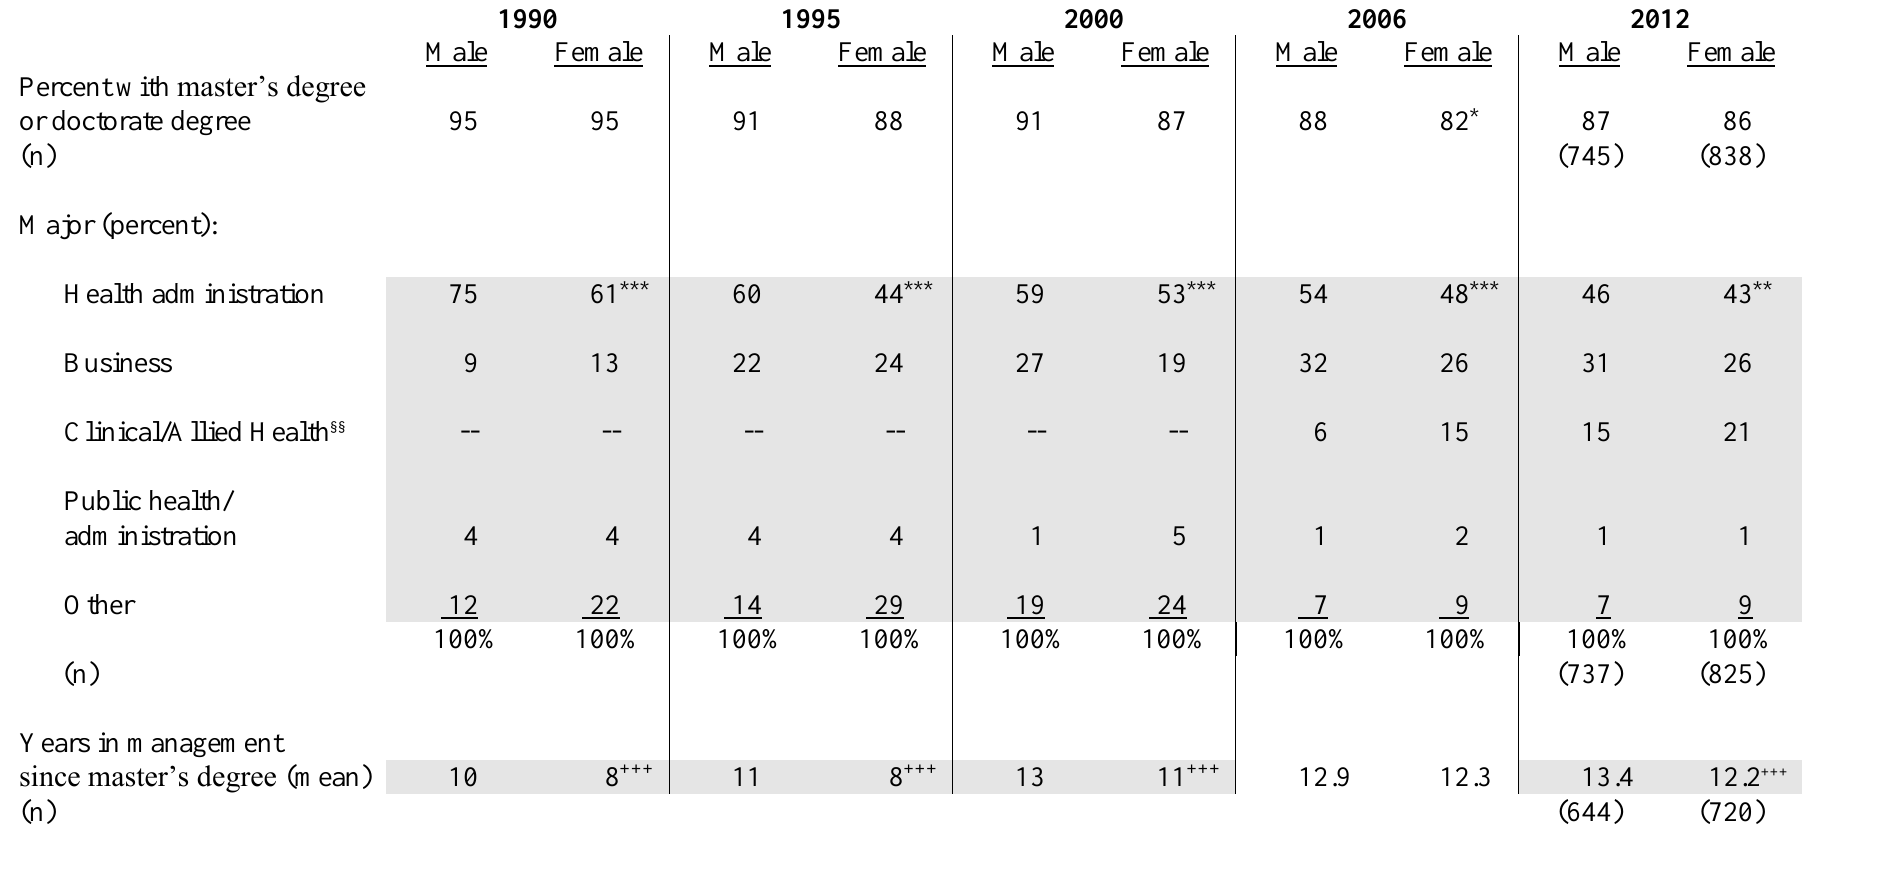
Table 12. Education § (percent)